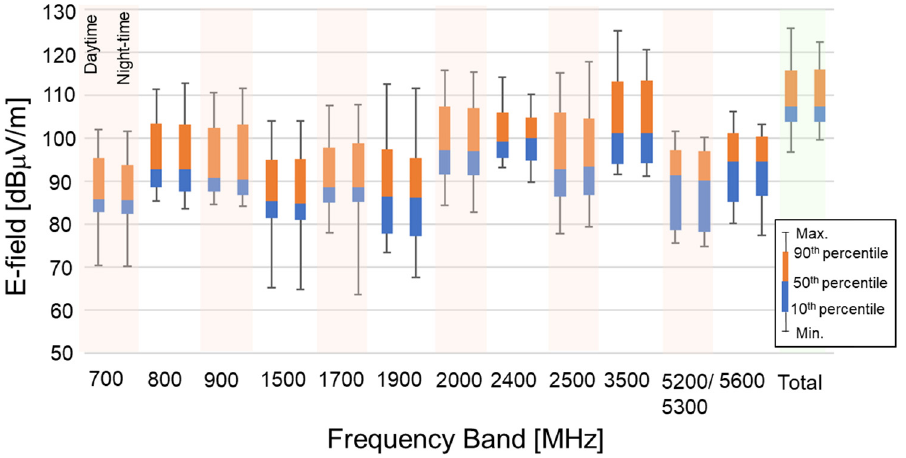
Figure 4. Statistical distribution of E-field strength in each frequency band and total frequency bands in the mall.